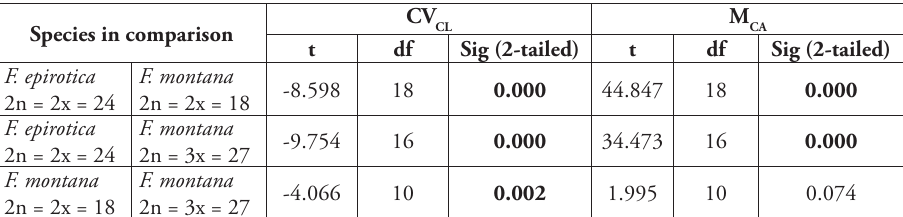
Table 5. Paired t-tests between the three species regarding the CV dom (df) and Significance (Sig) for every parameter. Bold characters are used for P (Sig 2-tailed) under 0.01, which reveal significant statistical difference.